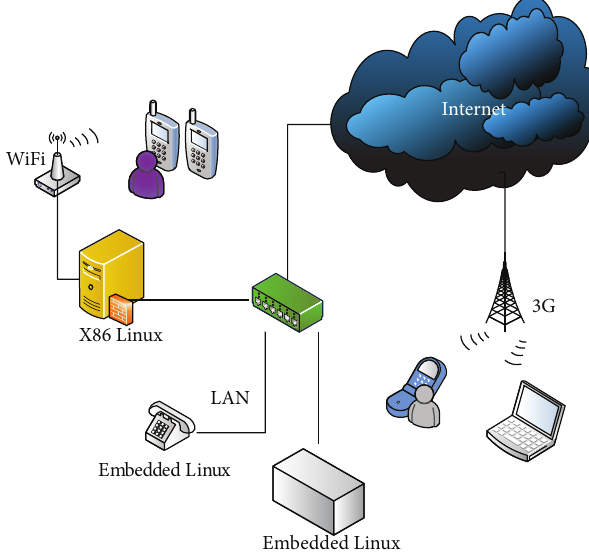
Figure 9: The deployment over heterogeneous networks.